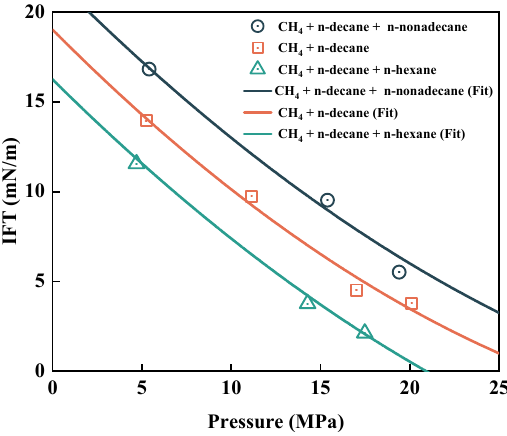
Figure 8. IFT of CH 4 /n-decane before and after CO 2 injection at 313.3 K.